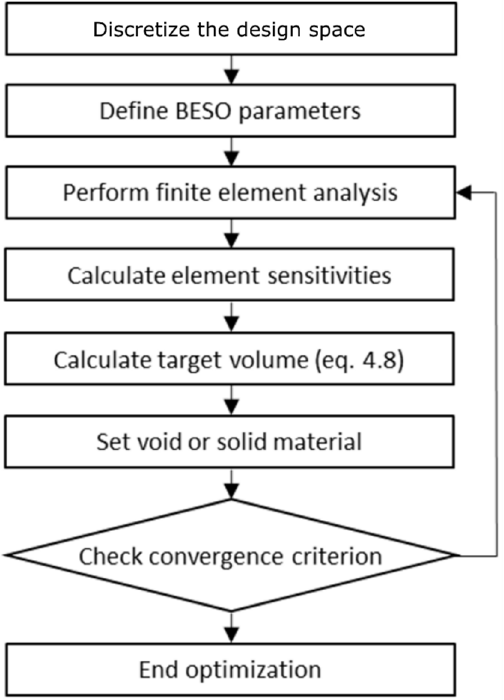
Figure 4. Summary of the BESO method. First, the design space and the boundary conditions are discretized in an FE model. Then the optimization parameters are defined. Within the iteration loop, the FE calculation is performed, the element sensitivities are calculated and material properties are assigned until the convergence criterion is reached.